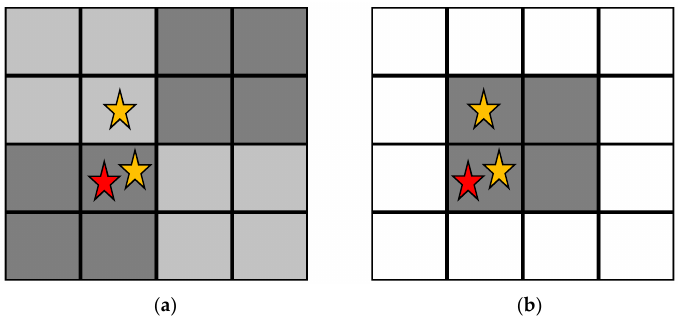
Figure 1. A 16 pixel array containing 3 detected events, with the red star representing the first of these events to be detected. ( a ) Static charge sharing correction algorithms (CSCAs) predefine the various search areas (shades of grey) before any events are detected. ( b ) In contrast, dynamic CSCAs define search areas after an event is detected based on a predetermined rule. In this case, the dynamic 2 × 2 CSCA is being applied, so the 2 × 2 search area is defined such that the first detected event is in the bottom left pixel of the search area.